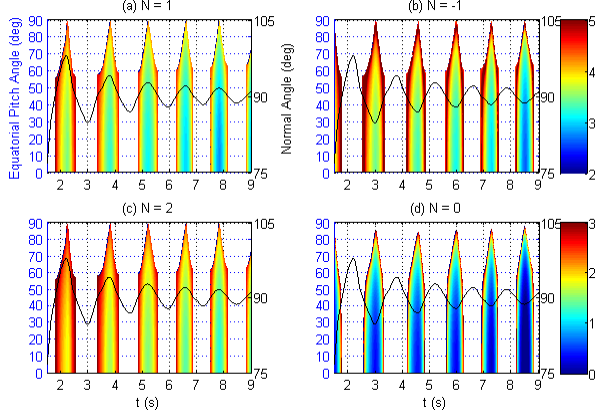
Figure 3. Electron resonant energies for various pitch angles along the ray path (within 1.5s–9s) of 1kHz waves launched from a lati- tude of 15 ◦ for four resonance harmonics: (a) N = 1, (b) N = − 1, (c) N = 2, and (d) N = 0. The curve of wave-normal angle along the ray path is shown in black. Here, (a)–(c) are indicated by the top color bar (10 2 –10 5 keV) and (d) are indicated by the bottom color bar (1–10 3